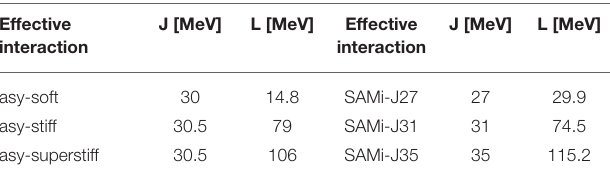
TABLE 1 | The values of the symmetry energy J and its slope L at normal density are reported for the Skyrme interactions adopted in our study. Effective interaction